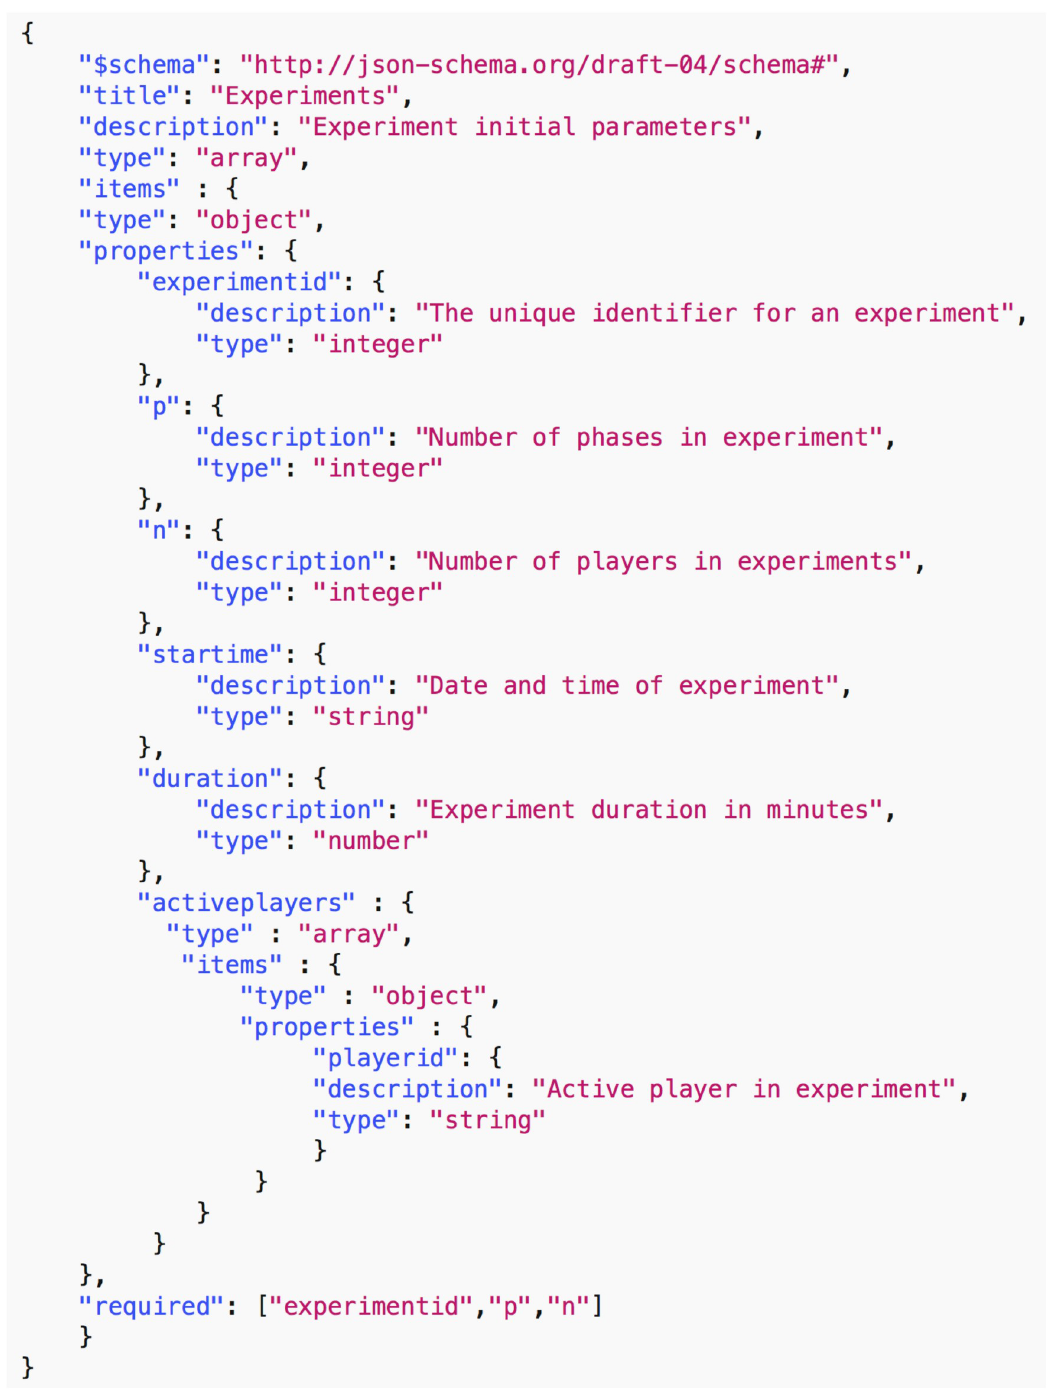
Fig 19. JSON schema for the “Experiment” of the data common specification.